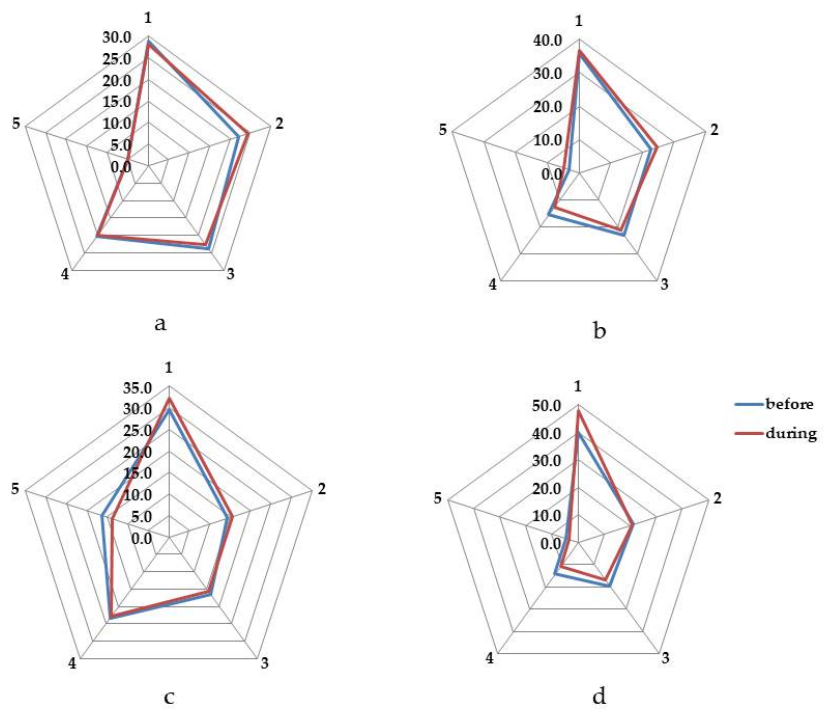
Figure 5. Ways of valorizing the food scraps (%). ( a ) prepare other dishes; ( b ) freezing for later use; ( c ) feeding animals; ( d ) throw away.